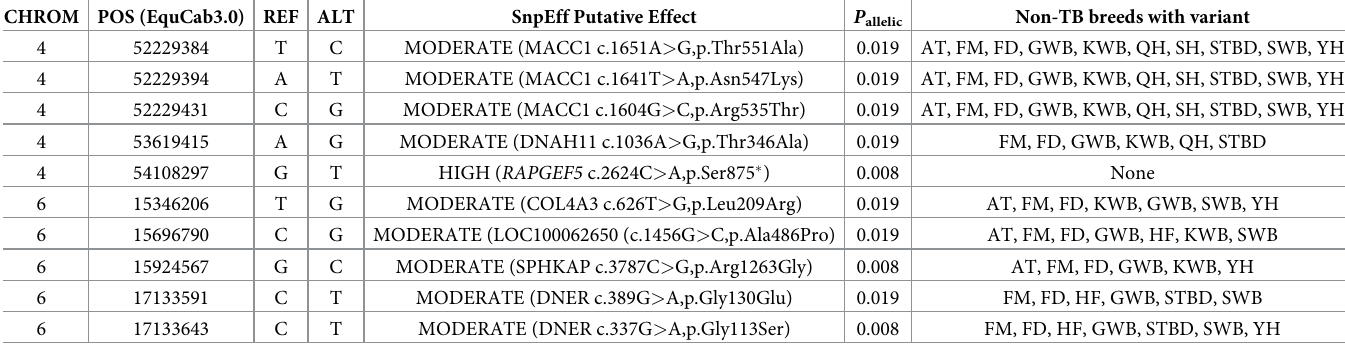
Table 1. ‘MODERATE’ and ‘HIGH’ genetic variants significantly associated with idiopathic hypocalcemia in Thoroughbred foals ( P allelic < 0.02). Associated variants in regions of homozygosity were screened across 123 horses within 12 breeds using the NCBI SRA database (https://ncbi.nlm.nih.gov/subs/sra/). AT = Akhal-Teke, FM = Franches-Montagnes, FD = Friesian dwarf, GWB = German Warmblood, HF = Haflinger, ICE = Icelandic, KWB = Koninklijk Warmblood, QH = Quarter horse, SH = Shetland pony, STBD = Standardbred, SWB = Swiss Warmblood, YH = Yakutian horse. At the time of screening, no other Thoroughbreds (TB) were identified in the NCBI SRA database.